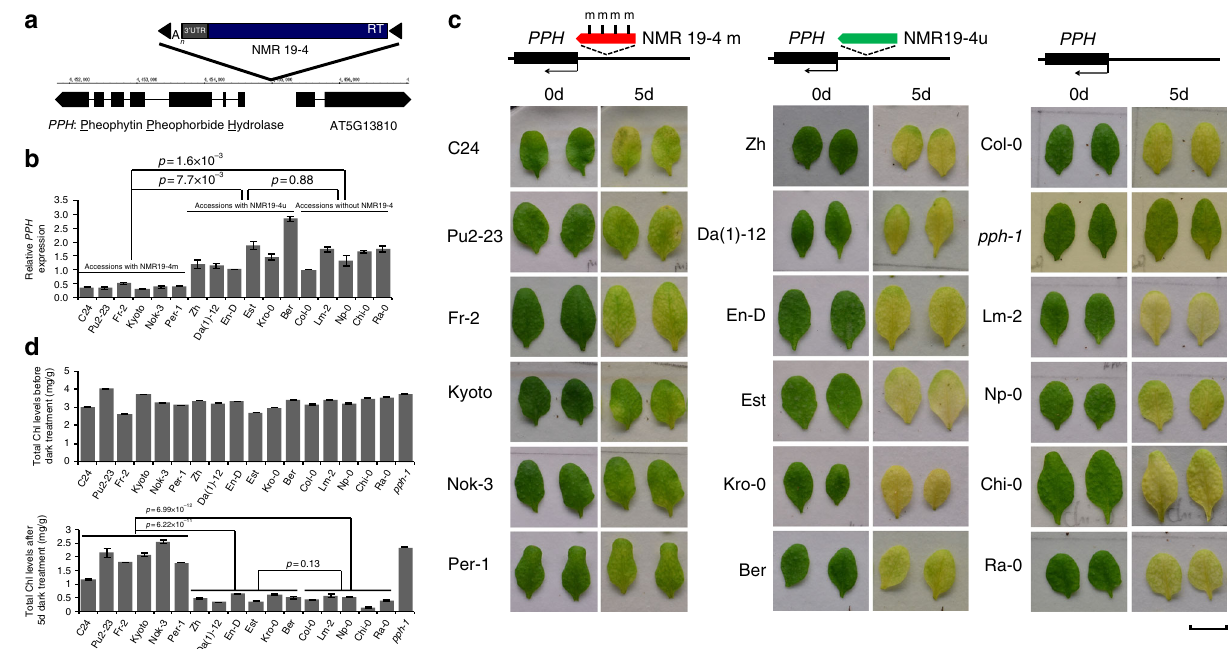
Fig. 5 Methylation of NMR19-4 is negatively associated with leaf senescence. a The fl anking gene structure of NMR19. black box: exon; black line: intron. Tip of the black box in gene structure depicts direction of transcription. b The expression of PPH was repressed in accessions with NMR19-4m as compared to the accessions with NMR19-4u or deleted NMR19. p -value was calculated by a two-tailed t -test, the same below. Error bars are de fi ned as s.e.m. ( n = 3). The expression and Chl content data of all accessions are listed in Supplementary Data 2. c Top schematic diagram depicts the classi fi cation of NMR19-4 into three different groups, i.e., methylated, unmethylated and deletion, and the leaf pictures below each group show darkness-induced leaf senescence phenotype in various A. thaliana accessions. Photographs were taken from the detached leaves before (0 d) or after incubation in darkness for 5 d, and pph- 1 , a null mutant of PPH in Col-0, was used as a control. Scale bars, 1 cm. d Quanti fi cation of chlorophyll content before and after 5 days of dark treatment in various accessions of A. thaliana . Chl, chlorophyll. Error bars are de fi ned as s.e.m. ( n =